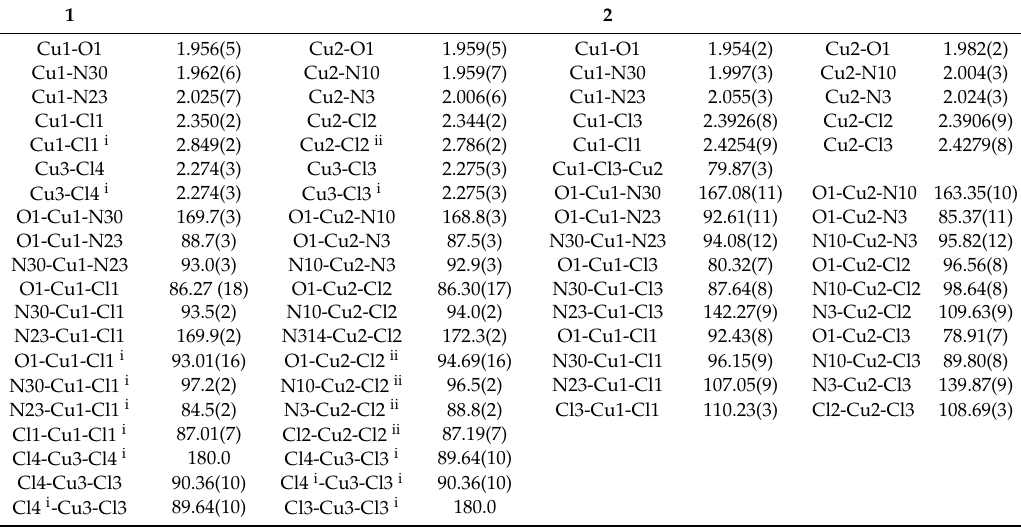
Table 1. Selected bond lengths [Å] and valence angles [ ◦ ] for 1 and 2